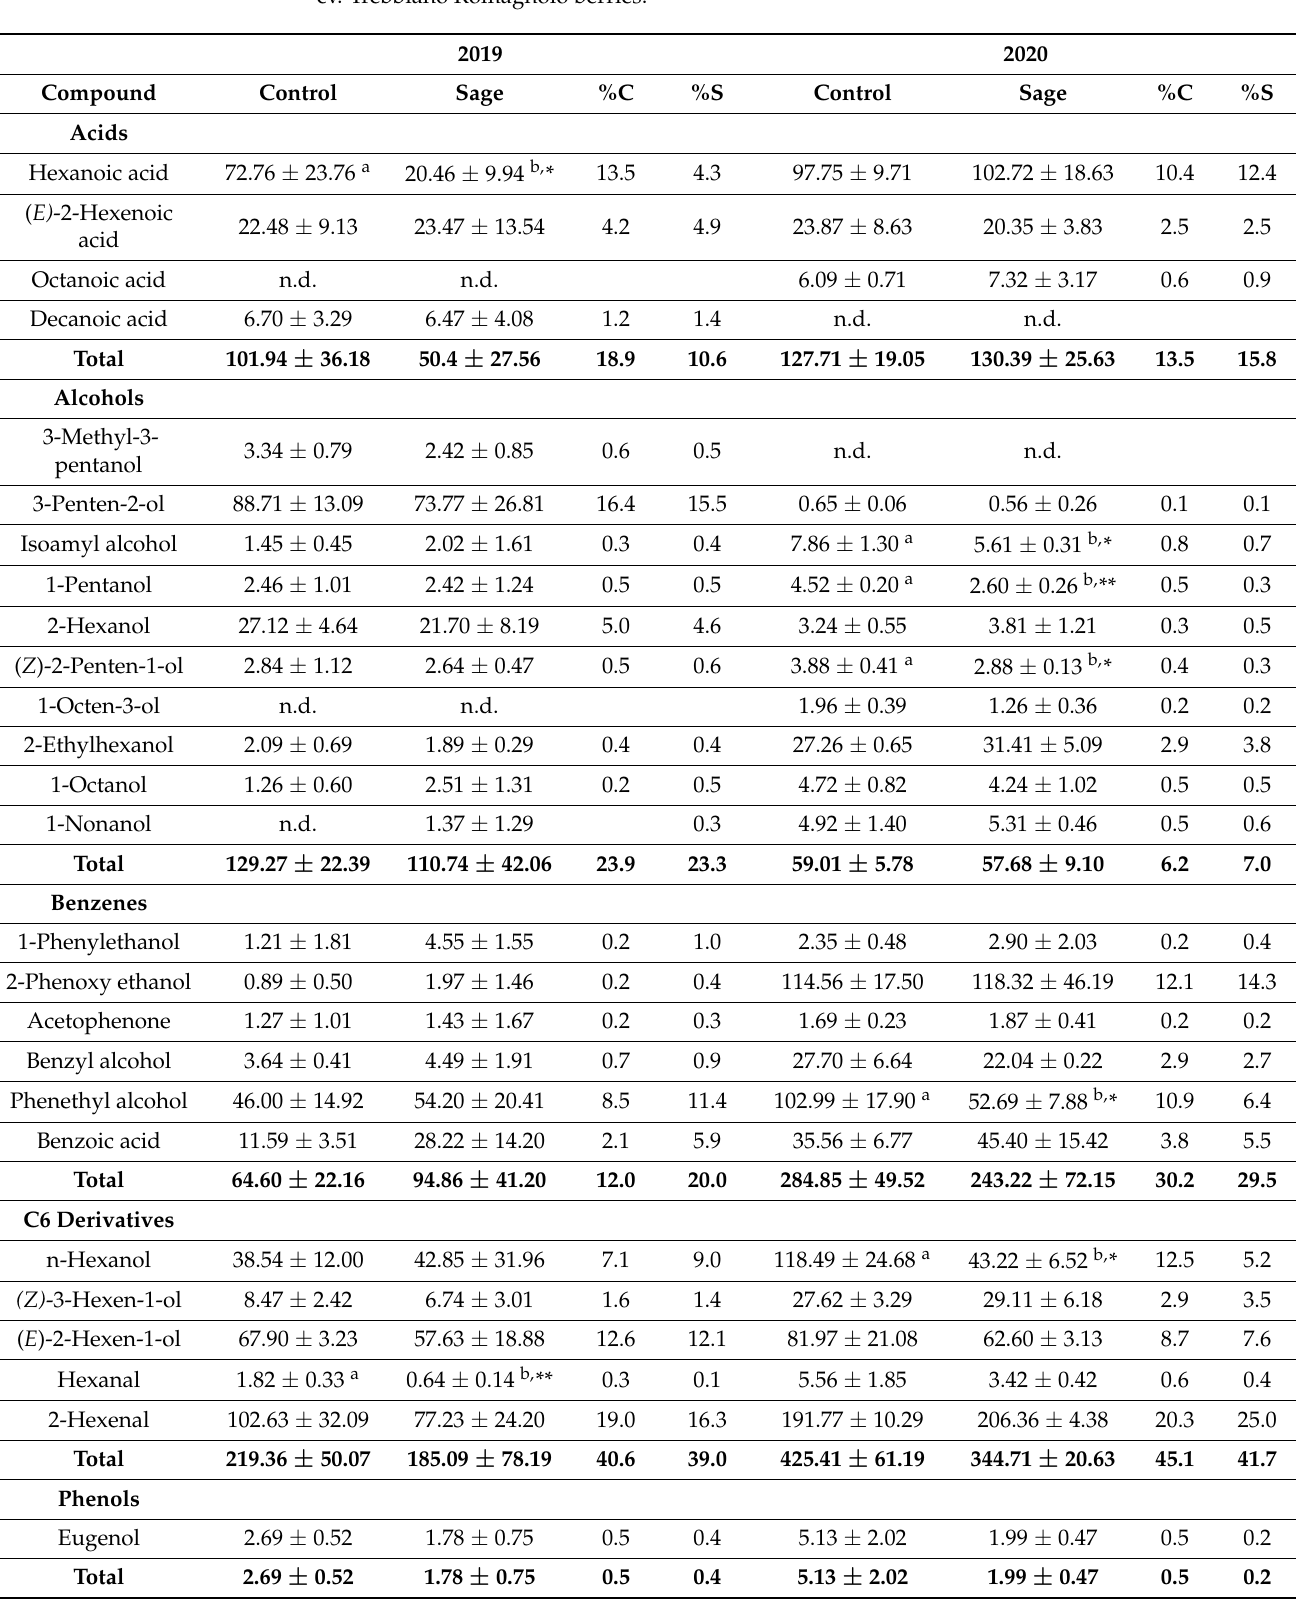
Table 3. Concentration ( µ g kg − 1 fw) and percentage of free volatile organic compounds detected in cv. Trebbiano Romagnolo